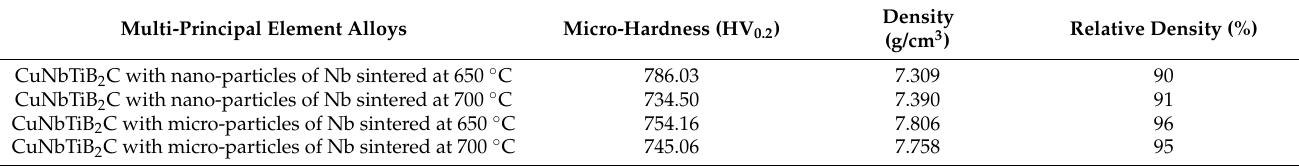
Table 2. Summary of the micro-hardness, density, and relative density of the sintered alloys.